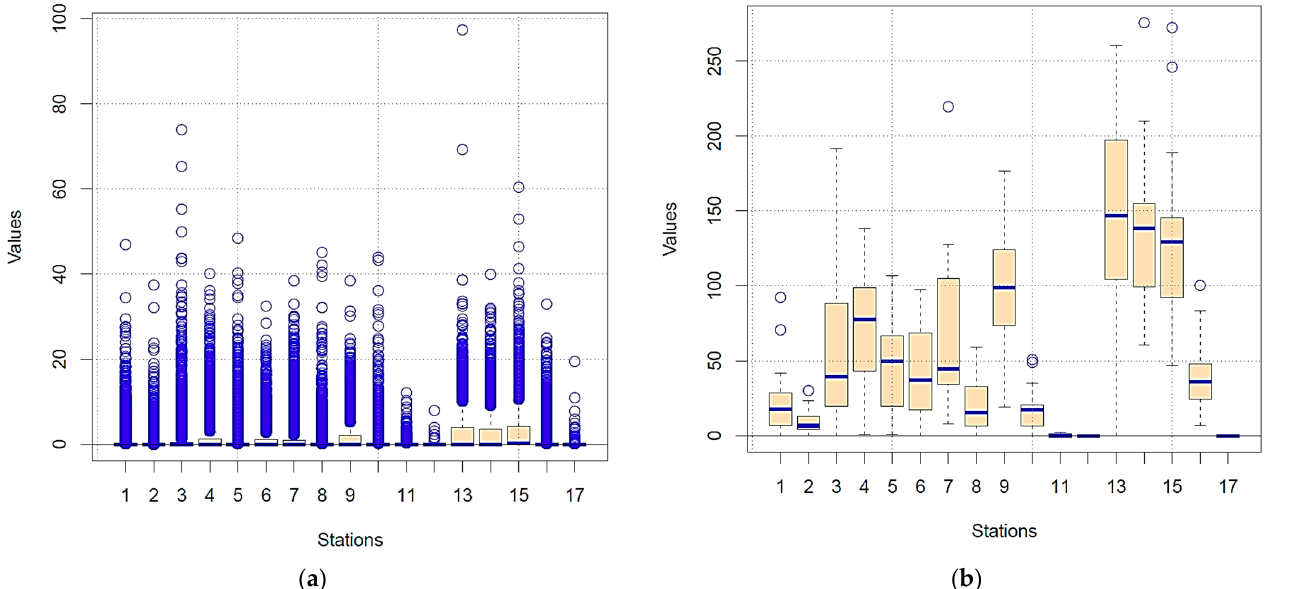
Figure 4. Exploratory analysis of outliers: ( a ) Daily series and ( b ) Monthly series.